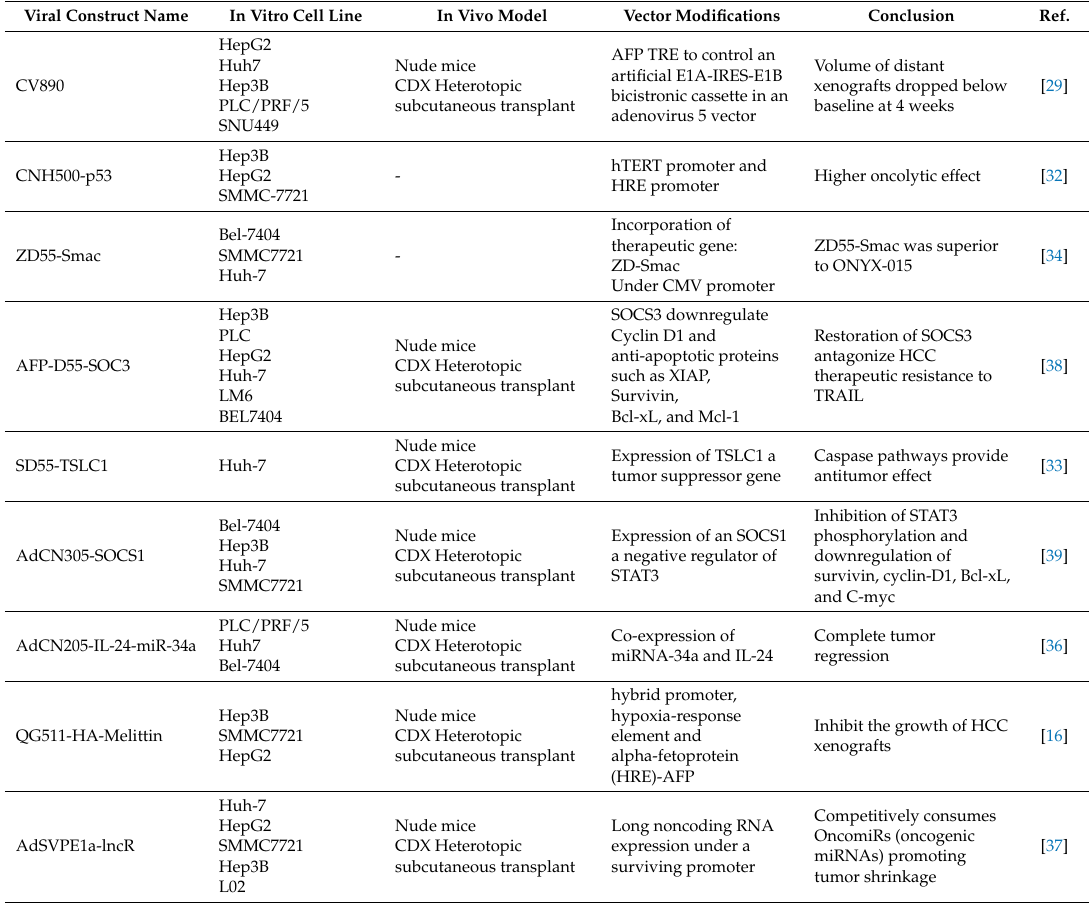
Table 5. Preclinical research in liver